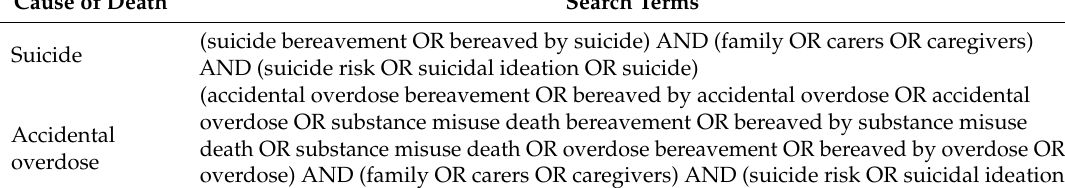
Table 1. Search strategy by bereavement group.